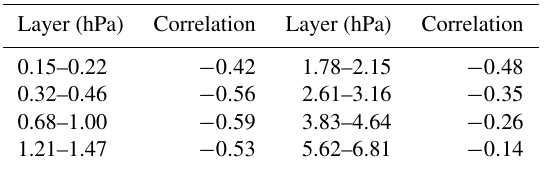
Table 1. Correlation between OMI–convolved MLS ozone differ- ences and PMC albedo residuals at 267nm as shown in Fig. 4 but for SH 2008 summer.